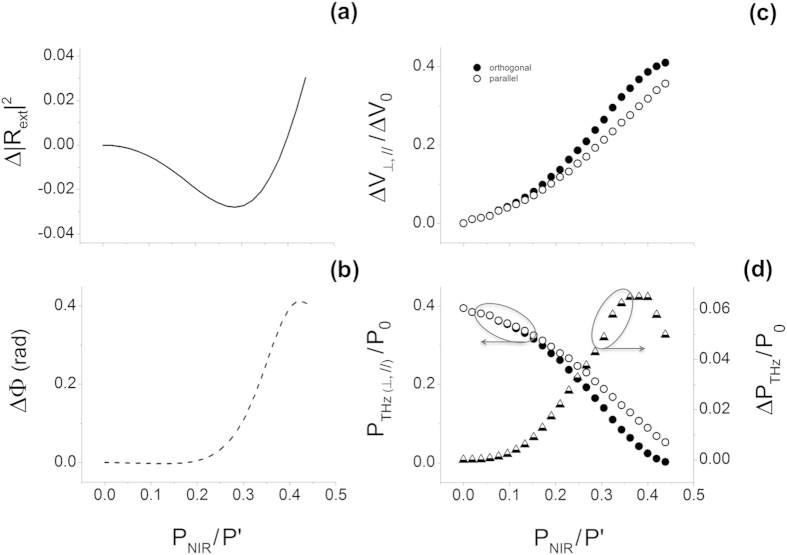
Analysis of Lang-Kobayashi model with target anisotropy predicted by the effective medium theory.Panel (a,b): Variation with the normalized power density of the optically induced difference in the modulus (Δ|Rext|2) and phase (ΔΦ) of the Si reflection coefficient for orthogonal and parallel polarization (see definition in the text). Panel (c,d): Corresponding THz QCL voltage change and emitted power density. The latter is normalized on the maximum value P0 at the fully developed constructive interference. The difference between emitted power in case of perpendicular and parallel polarization (ΔPTHZ) is also shown [triangles in panel (d)]. The grating period is assumed Λ ≪ λTHZ. Parameters have been taken from literature2427. The values of the other parameters used in simulations are: τr,e = τr,h = 3.23 × 10−13 s; me* = 0.27m0 and mh* = 0.37m0 (m0 being the electron mass); N* = 1018 m−3; ε∞ = 11.7+i0.01; Α = 800 cm−1; TNIR = 0.45; nNIR = 3.4; β = 1.25 × 1021 m−1W−1, τc = 37.4 × 10−12 s; τp = 32.4 × 10−12 s; W = 1.5; α = 1.5; Σ = ε(1 − R2)/R = 0.03.